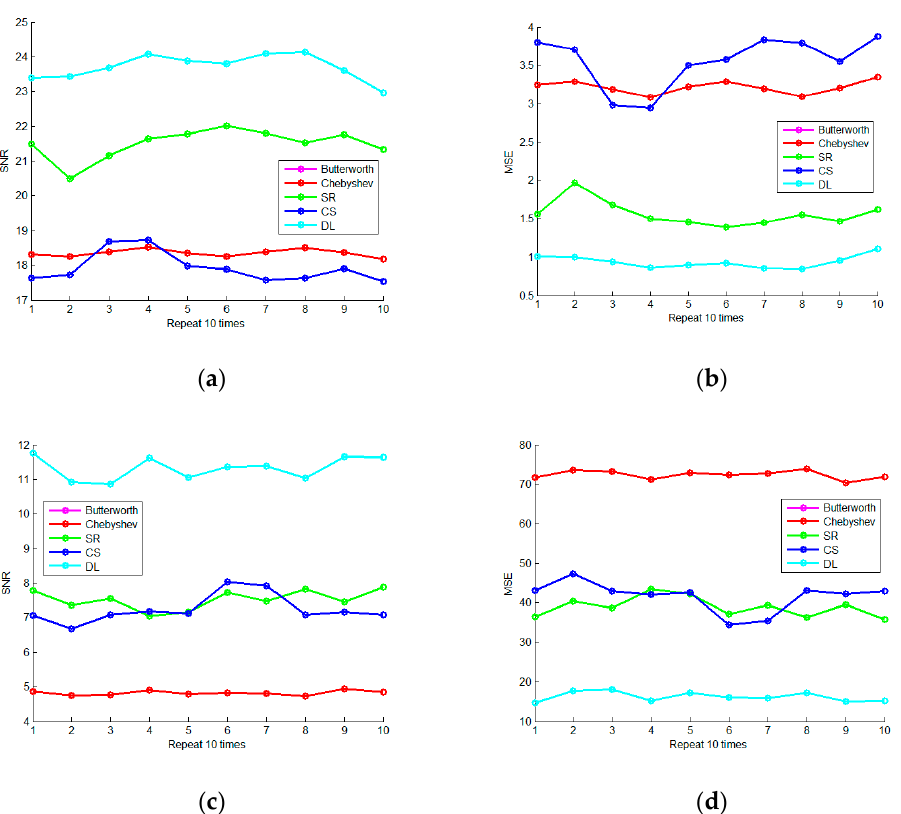
Figure 14. The Repeated Denoising Experiment ( a ) is the 10-times repetitive SNR curve of FIR filtering and three sparse methods when sigma is 2; ( b ) is the 10-times repetitive MSE curve of the denoising methods when sigma is 2; ( c ) is the 10-times repetitive SNR curve of the denoising methods when sigma is 10; ( d ) is the 10-times repetitive MSE curve of the denoising methods when sigma is 10. Change the sigma from 1 to 10 in turn, as shown in Figure 15. It proves again that the spare denoising method based on the learning-type dictionary is indeed better than other sparse and filtering denoising methods.